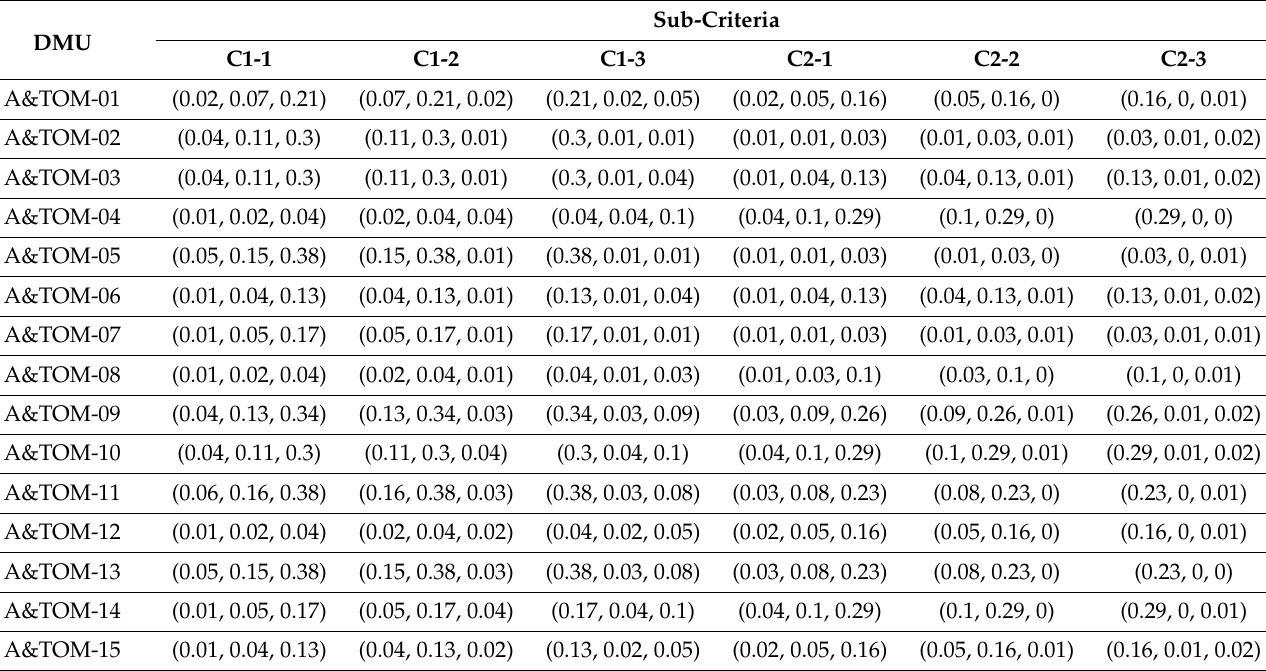
Table A3. Weighted normalized fuzzy decision